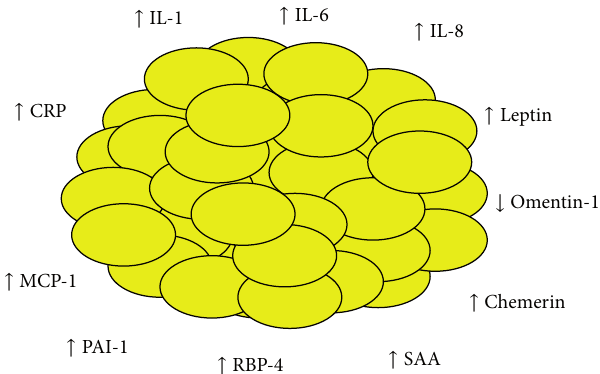
Figure 1: Schema depicting adipokine dysfunction in metabolic syndrome. Abbreviations: MCP-1, monocyte chemotactic protein-1; RBP-4, retinol-binding protein-4; SAA, serum amyloid A; CRP, C-reactive protein; IL, interleukin; PAI-1, plasminogen activator